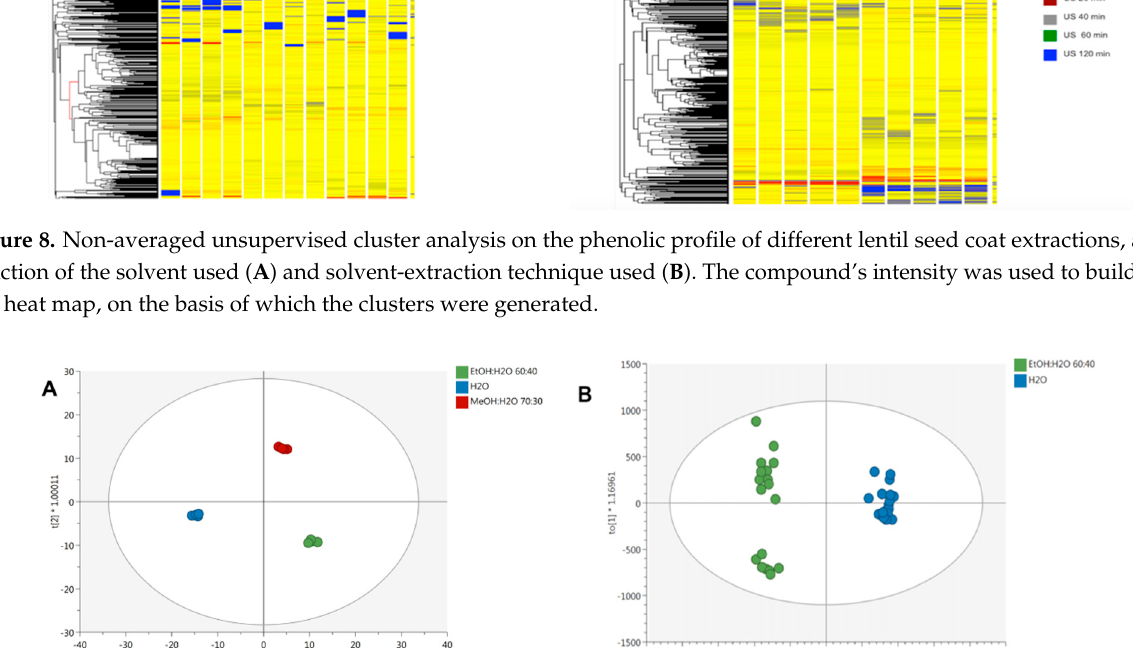
Figure 9. Orthogonal projection to latent structures discriminant analysis (OPLS-DA) on phenolic profiles of different lentil seed coat extracts, as a function of the solvent used ( A ) and solvent-extraction technique used ( B ). Individual repli- cations are given in the class prediction model score plot.